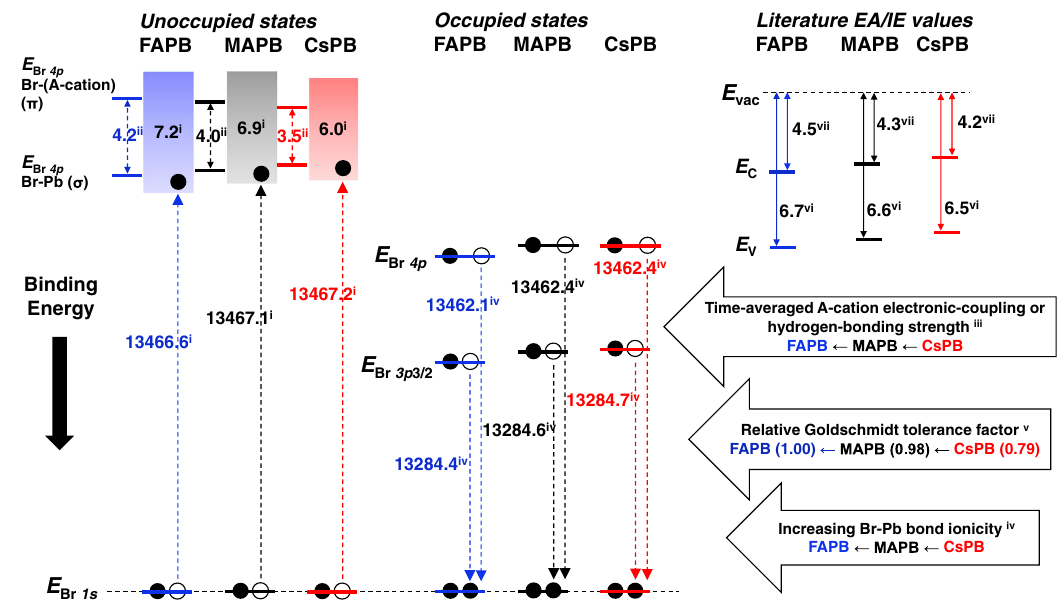
Fig. 5 Summary of energy level positions derived from experiment and calculation and correlations found. One-electron transitions are shown for the X-ray absorption and emission processes. The origin of each numerical value or correlation is indicated with a superscript identi fi er. Values obtained via experimental Bromine K -edge High Energy Resolution Fluorescence Detected X-ray Absorption Spectroscopy (Br K HERFD-XAS) measurements are identi fi ed with superscript i. Values derived from calculated Br K XAS are identi fi ed with superscript ii. The correlation obtained from calculated bromine projected density of states (Br PDOS) is identi fi ed with superscript iii. Values obtained via experimental Bromine K -edge X-ray Emission Spectroscopy (Br K XES) measurements are identi fi ed with superscript iv. The correlation obtained from Goldschmidt tolerance factors, calculated using parameters from the literature, is identi fi ed with superscript v. Values for the ionization energy, abbreviated as IE , are obtained from Ultraviolet Photoelectron Spectroscopy (UPS) measurements reported in the literature and are identi fi ed with superscript vi. Values for the electron af fi nity, abbreviated as EA , are obtained from Inverse Photoelectron Spectroscopy (IPES) measurements reported in the literature and are identi fi ed with superscript vii. A-cation electronic coupling or hydrogen-bonding strength refers to the strength of coupling between the A-cation and Br-Pb sublattice. Electron af fi nity and ionization energy values from the literature are shown for the purpose of comparing trends 11 . The connection between this work and the work reported in the literature is described in the